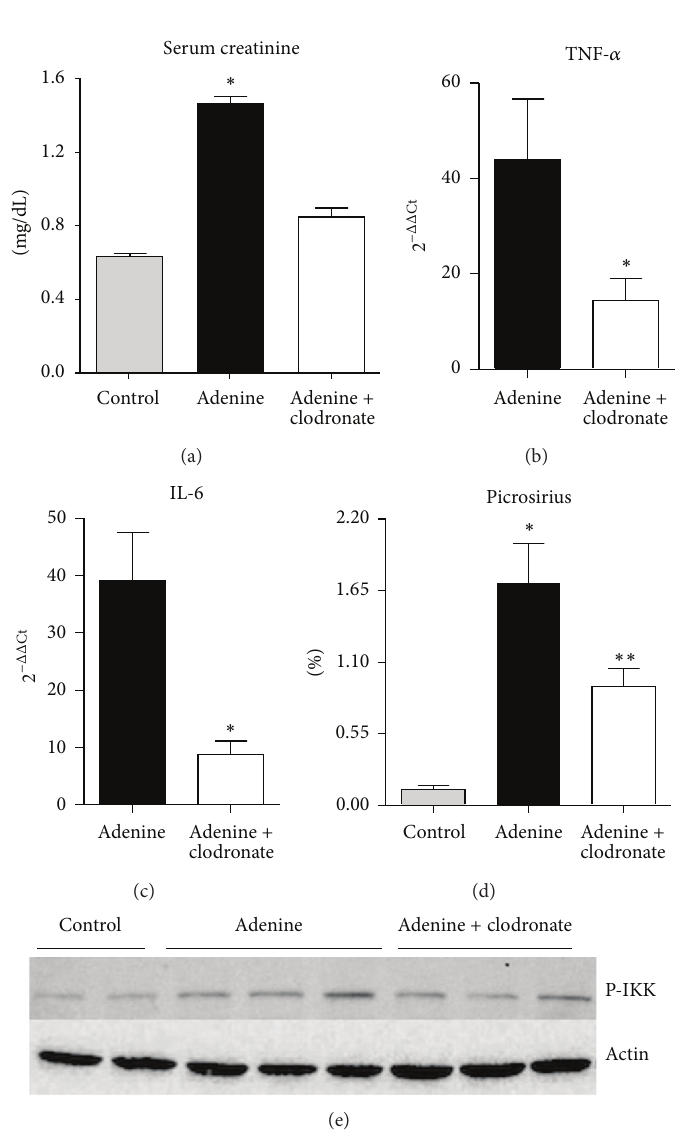
Figure3:Macrophagedepletionleadstoprotectioninadenine-inducedTIN.(a)Renalfunctionofcontrol,adenine,andadenine+clodronate mice was evaluated by serum creatinine ( ∗ 𝑃 < 0.05 versus control and adenine + clodronate). The inflammatory profile from these animals wasmeasuredandindicatedbythelevelsofTNF- 𝛼 andIL-6(panels(b)and(c),resp., ∗ 𝑃 < 0.05 versusadenine).Also,fibrosiswasassessedby the picrosirius staining (panel (d), ∗ 𝑃 < 0.05 versus control and adenine + clodronate and ∗∗ 𝑃 < 0.05 versus control). (e) Protein expression of p-IKK in control, adenine, and clodronate treated